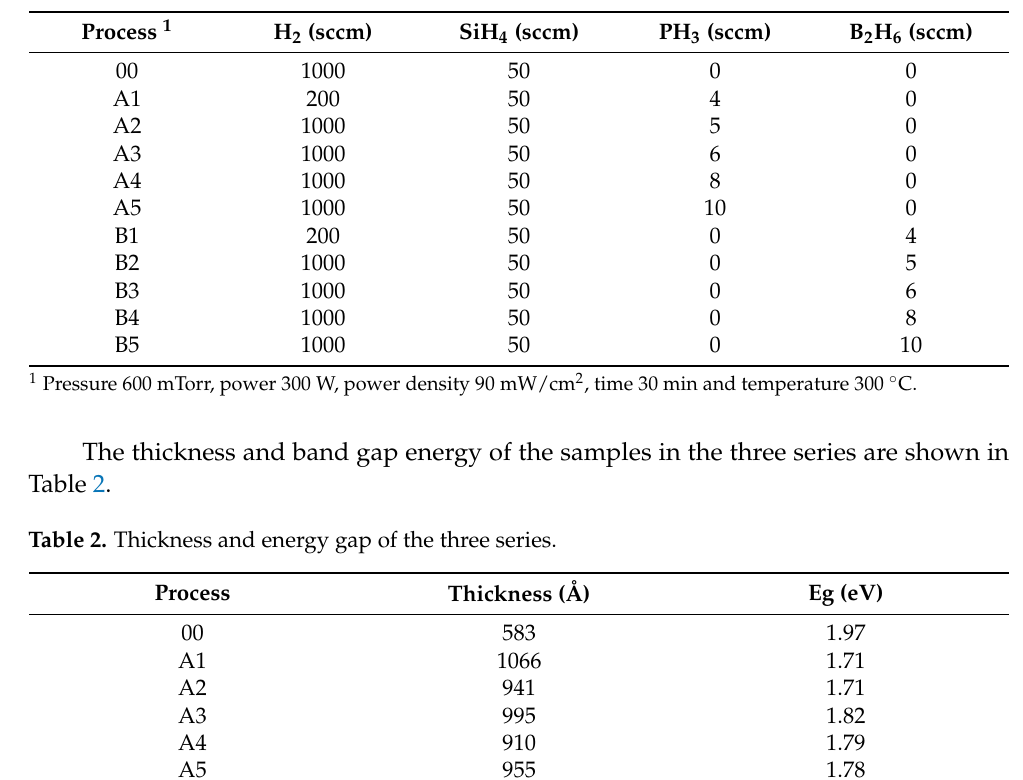
Table 1. Gas flows of H 2 , SiH 4 , PH 3 and B 2 H 6 for the first, second and third series.